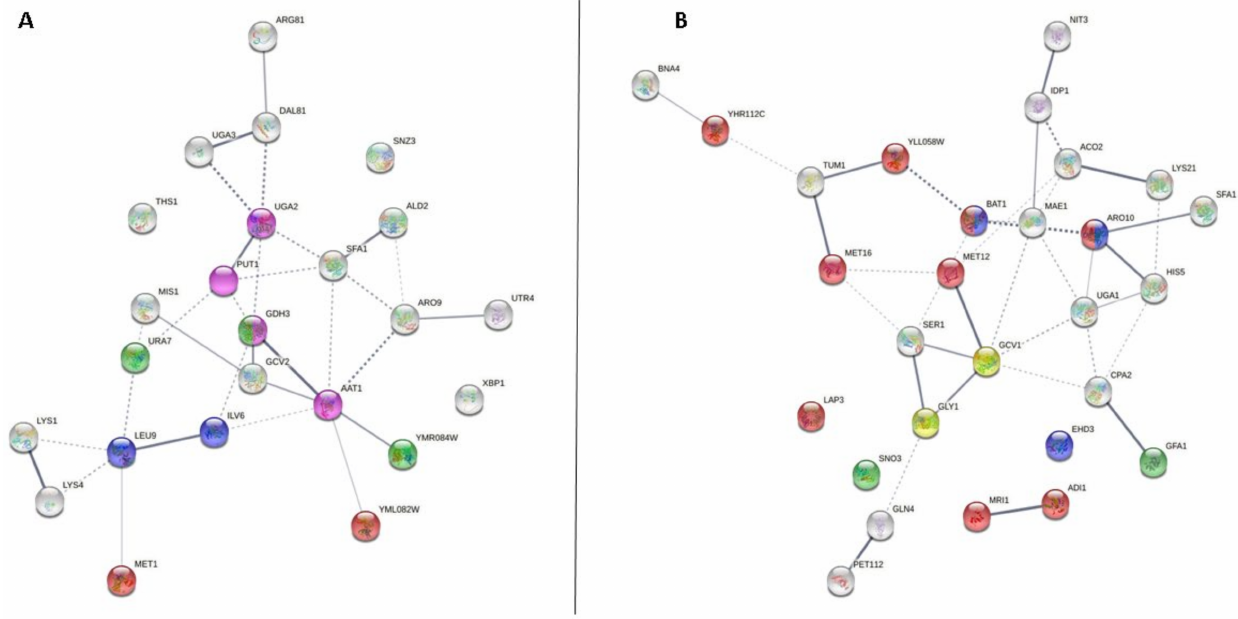
Figure 2. High confidence protein–protein interaction network map built using STRING v11 and based on the proteins of cellular amino acid metabolic process detected in S. cerevisiae P29 ( A ) and G1 ( B ) in the middle of the second fermentation. Proteins are shown as nodes, and the existence of interactions between them are represented by lines (the connection between nodes). Line thickness indicates the strength of the different interactions. Nodes with the same color represent specific clusters: sulfur amino acid metabolic process (red nodes), branched-chain amino acid metabolic process (light blue nodes), glutamine metabolic process (light green nodes), glycine metabolic process (yellow nodes), and glutamate metabolic process (light purple